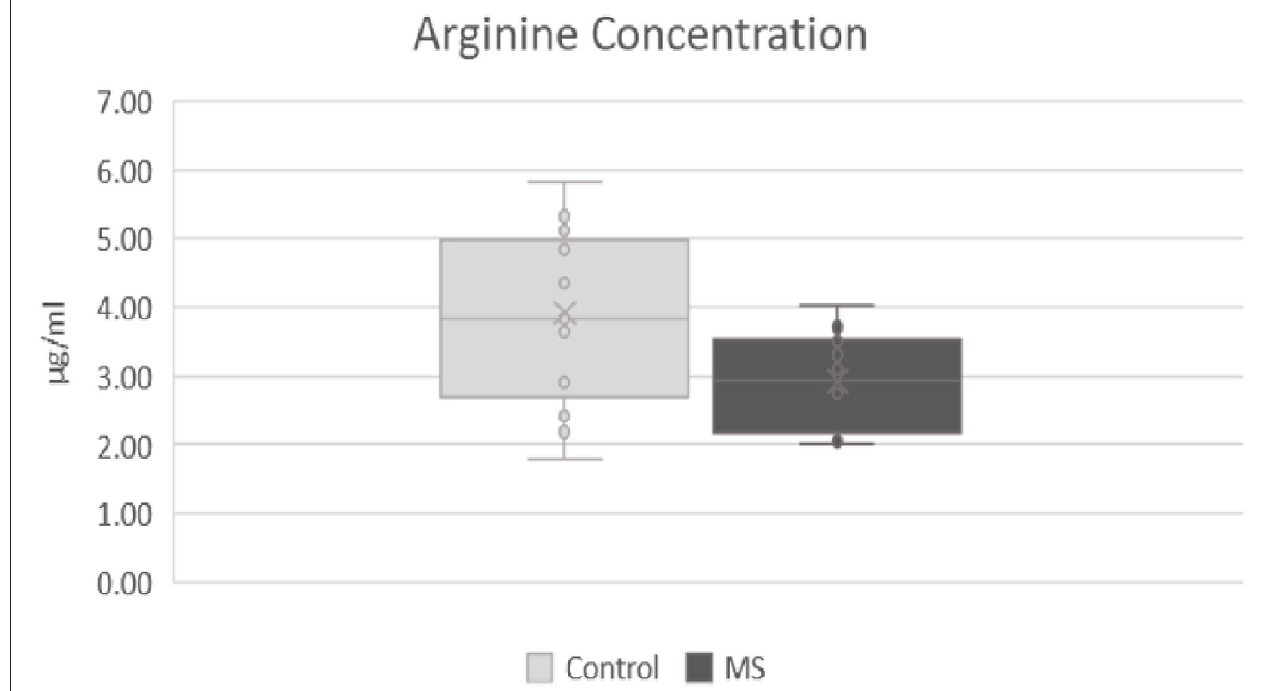
FIGURE 1 | Comparison of levels of arginine in patients after first attack of clinical symptoms fulfilling revised McDonald criteria and control group. MS, patients after first attack of clinical symptoms fulfilling revised McDonald criteria; control, control group.